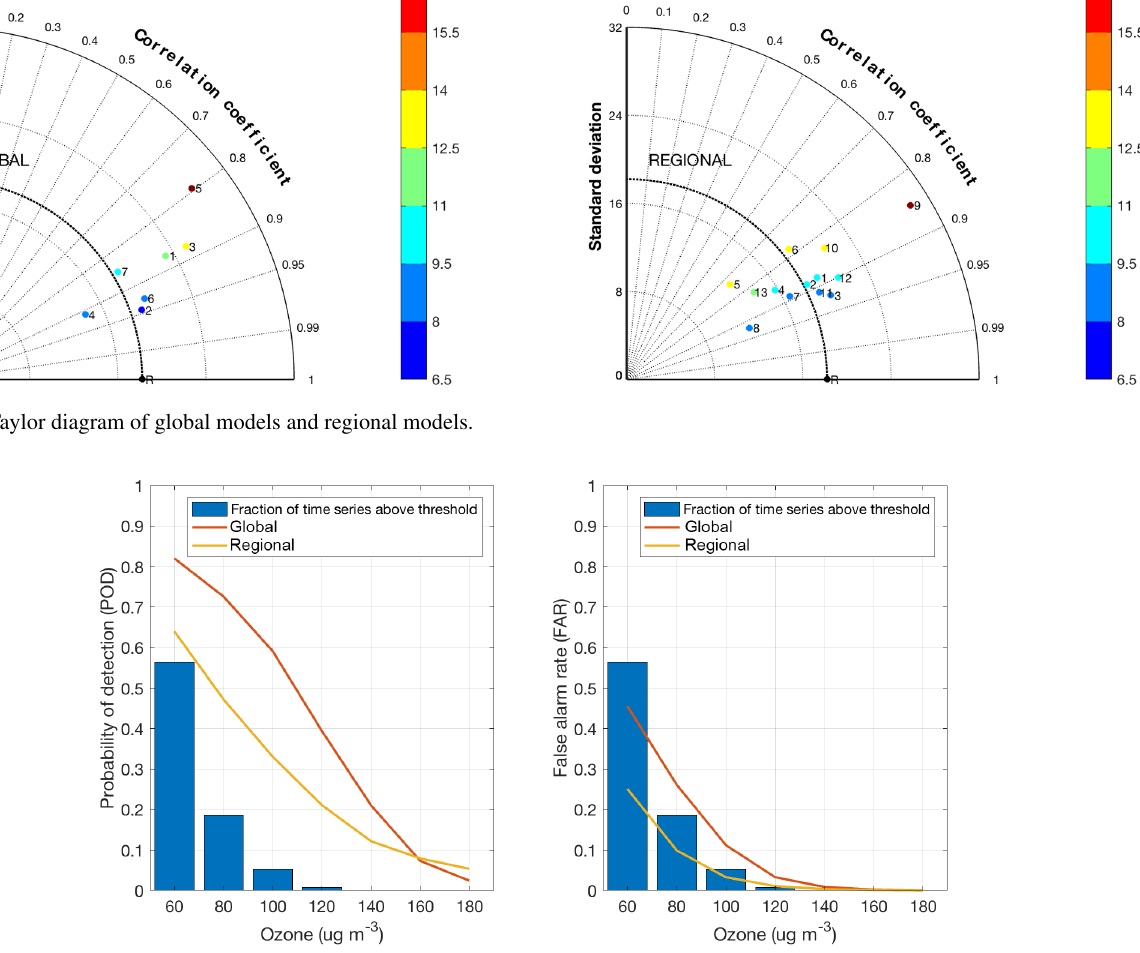
Figure 3. Cumulated probability of detection (POD) and false-alarm rate (FAR) for global and regional models at various ozone concentration